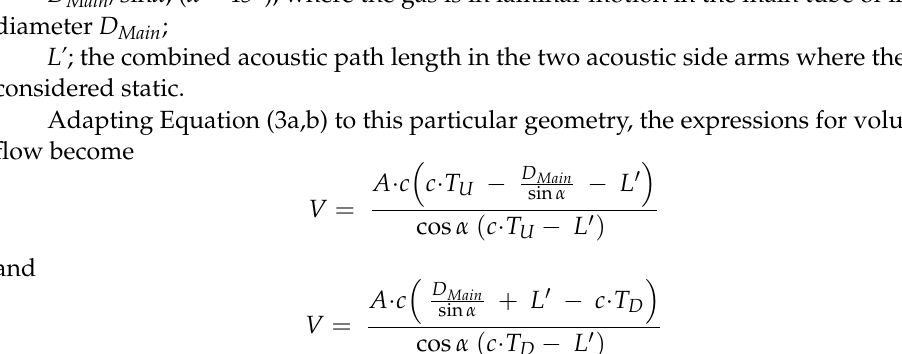
Figure 3. Angled ultrasonic flowmeter in the vapor return line of the ATLAS C 3 F 8 thermosiphon (‘TS’) recirculator.